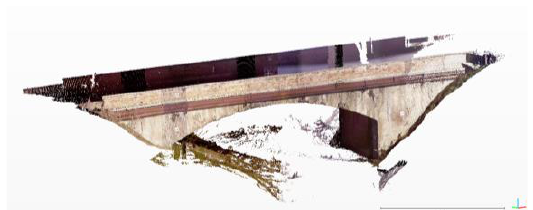
Figure 6. TLS point cloud of the Cortemaggiore bridge (Piacenza, Italy).